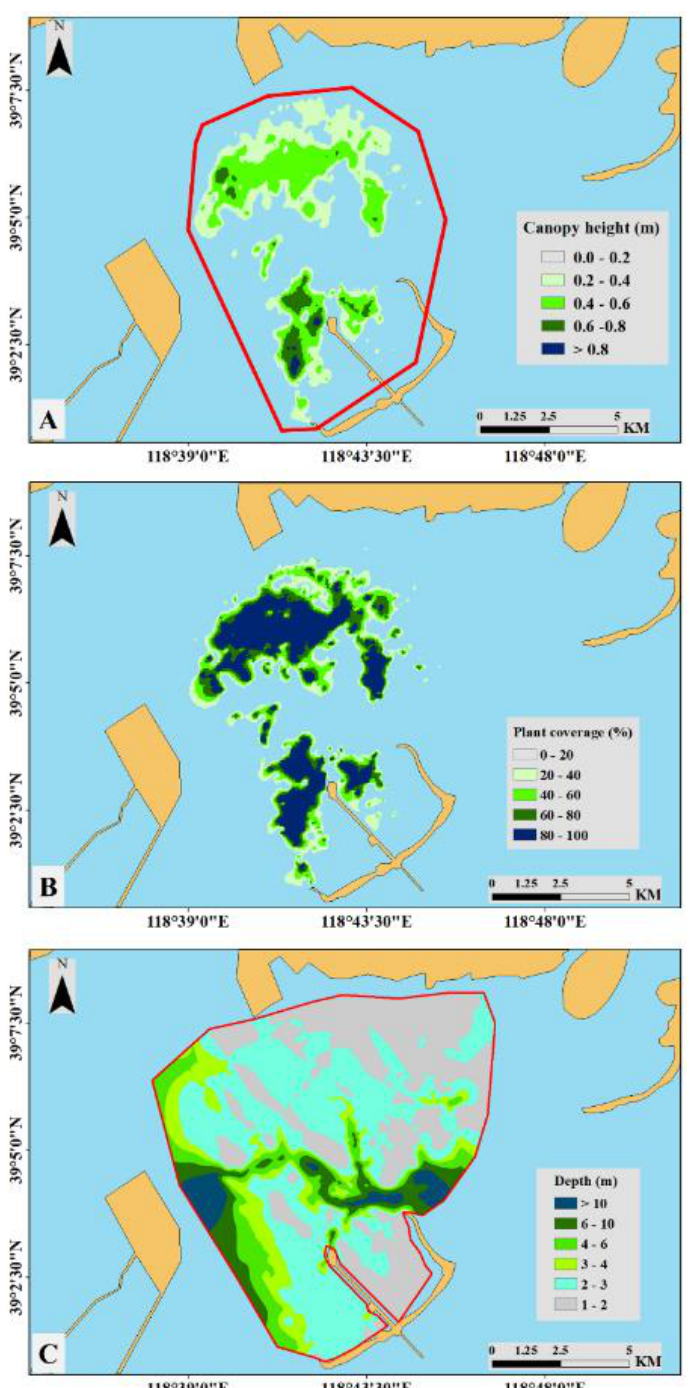
Figure 5. Eelgrass distribution map of plant canopy height ( A ), coverage ( B ), and water depth ( C ) generated from the interpolation analysis of the study area in August 2018. The area marked by the red polygon in A is the peripheral area of the seagrass beds. The red polygon in C marks the area used for the interpolation analysis.